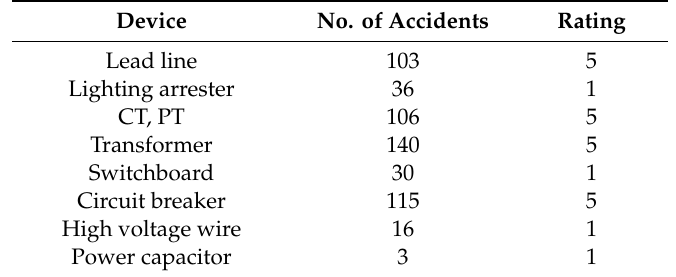
Table 9. The number of accidents and risk rating for high voltage